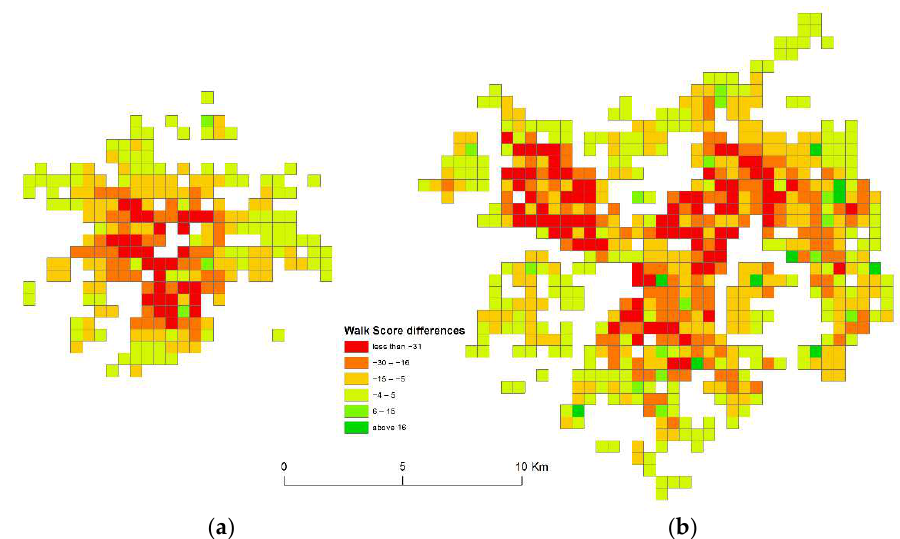
Figure 14. Differences between WS for the elderly and standard WS (HK ( a ), Ostrava ( b )). Improvement of walkability for the elderly seldom occurs, as expected, though in Ostrava, sparse isolated locations typically represent countryside-like settlement with in- dividual housing and good local shopping opportunities.